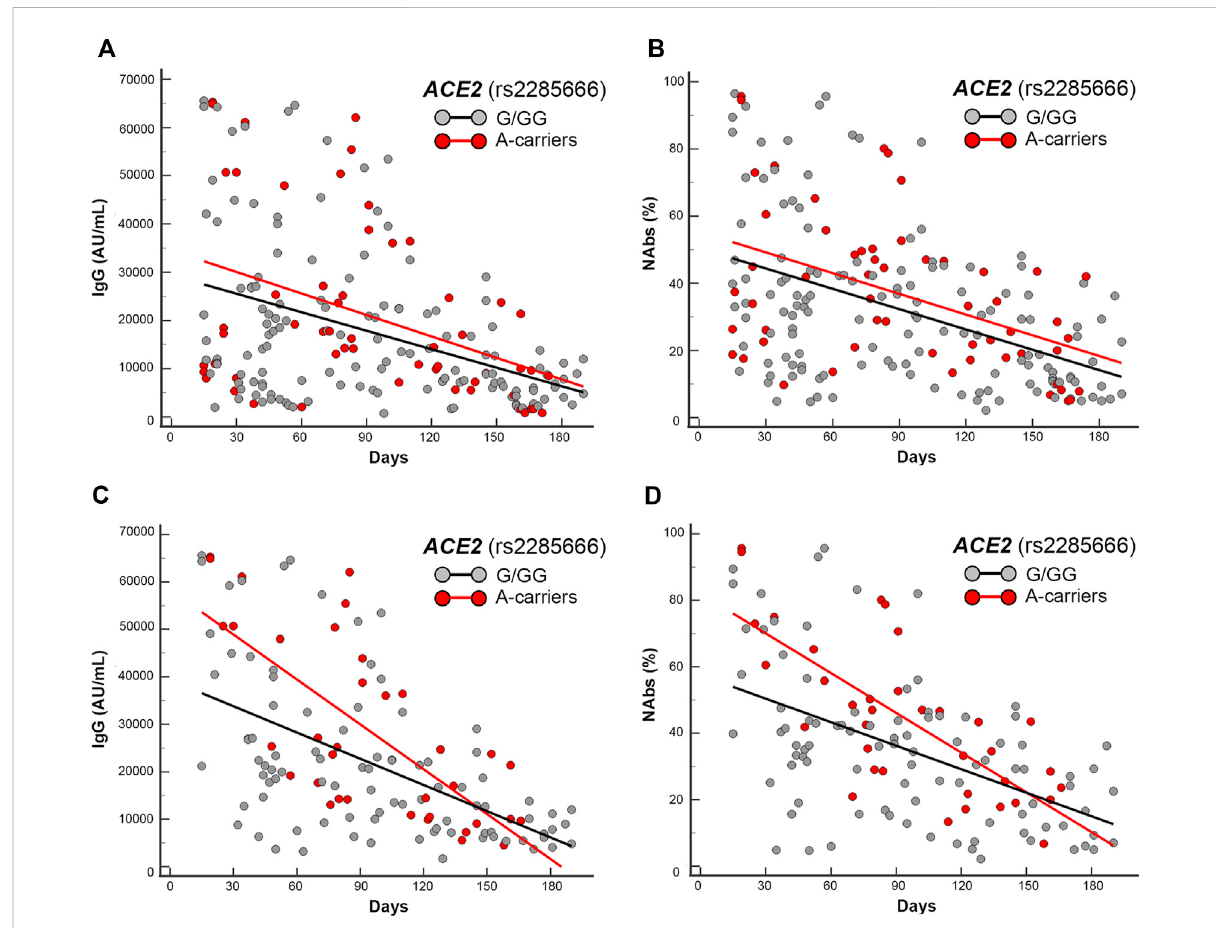
FIGURE 4 Scatter plots and regression analyses of IgG and NAbs levels strati fi ed by ACE2 (rs2285666) genotypes. (A,C) IgG and (B,D) NAbs kinetics in the whole cohort (A,B) and in the mRNA-based vaccine subgroup (C,D) . Each panel shows the speci fi c regression lines, according to the indicated